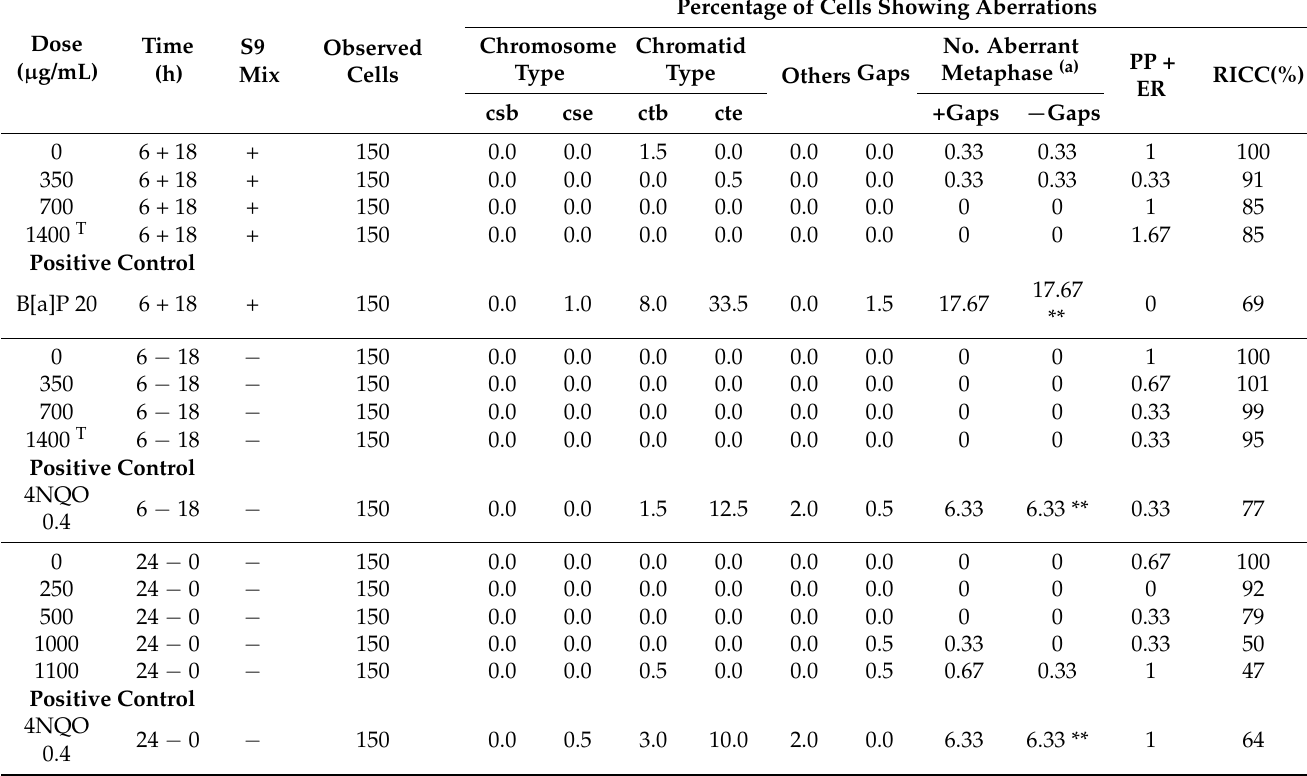
Table 2. In vitro chromosome aberration test of WG